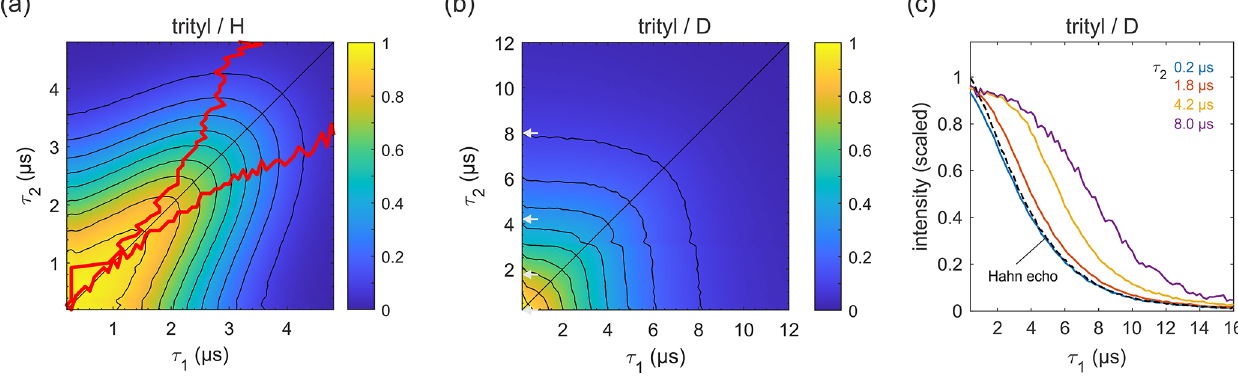
Figure 6. Refocused echo decays for 100µM trityl OXO63 in (a) H 2 O / glycerol (80 : 20 v/v ) and (b) D 2 O / glycerol-d 8 at 25K; in panel (a) , the red lines show the position of the echo maximum along τ 1 for each constant τ 2 (upper line) and vice versa (lower line). Panel (c) shows slices of the data in panel (b) along τ 1 for several τ 2 values (indicated by grey arrows in b ), together with a Hahn echo decay.